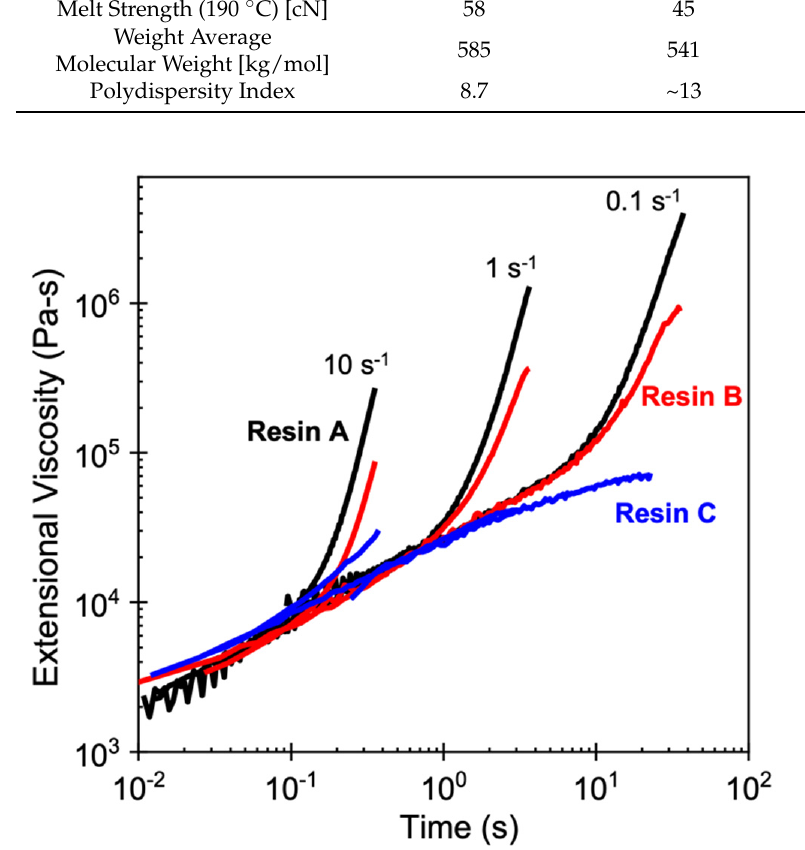
Figure 1. Extensional rheology of the three resins used for foaming studies in this work. Measurements were performed at 190 °C using an ARES-G2 rheometer with SER fixture based on the ExxonMobil test method EM514. SHR values at an extension rate of 1 s − 1 and a Hencky strain of 3 for Resin A, Resin B, and Resin C are 13, 5.6, and 1.0, respectively.